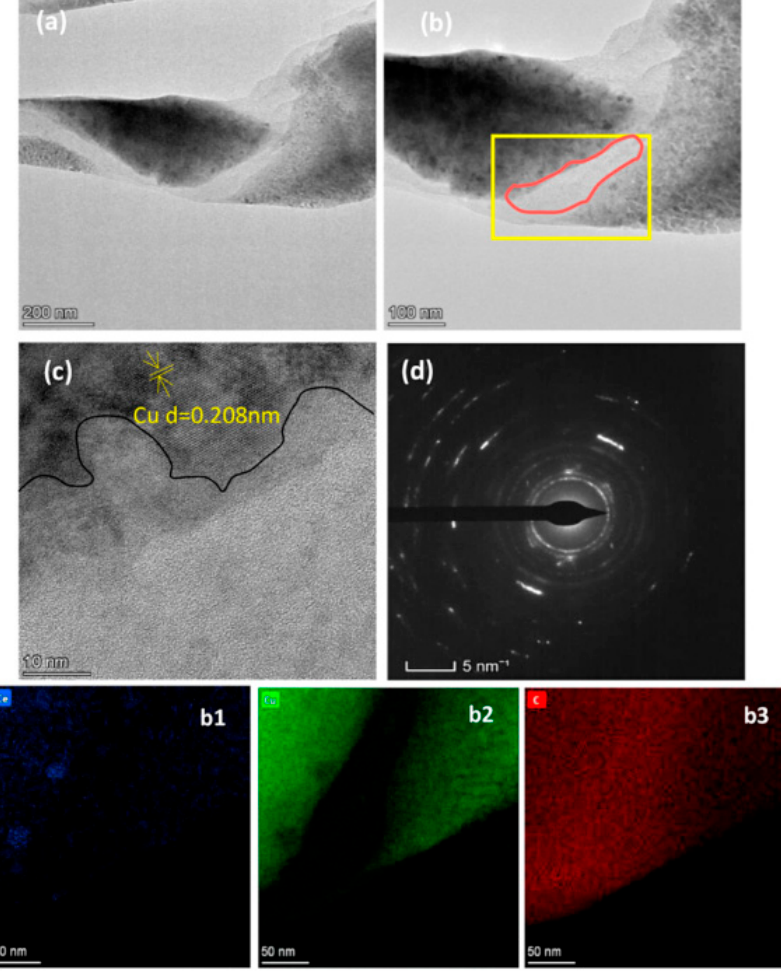
Figure 8. TEM, HRTEM images and EDS-mapping of Ce–rGO/Cu composite: ( a ) Low magnification TEM of Ce-rGO/Cu composite; ( b ) High magnification TEM; ( c ) HRTEM of yellow square in ( b ); ( d ) SAED patterns in red circle in ( b ) for Ce-rGO/Cu composite; EDS-mapping of ( b1 ) Ce element; ( b2 ) Cu element; ( b3 ) C element of which pattern [3]. Reprinted/adapted with permission from Ref. [3]. Copyright year 2021, Elsevier.